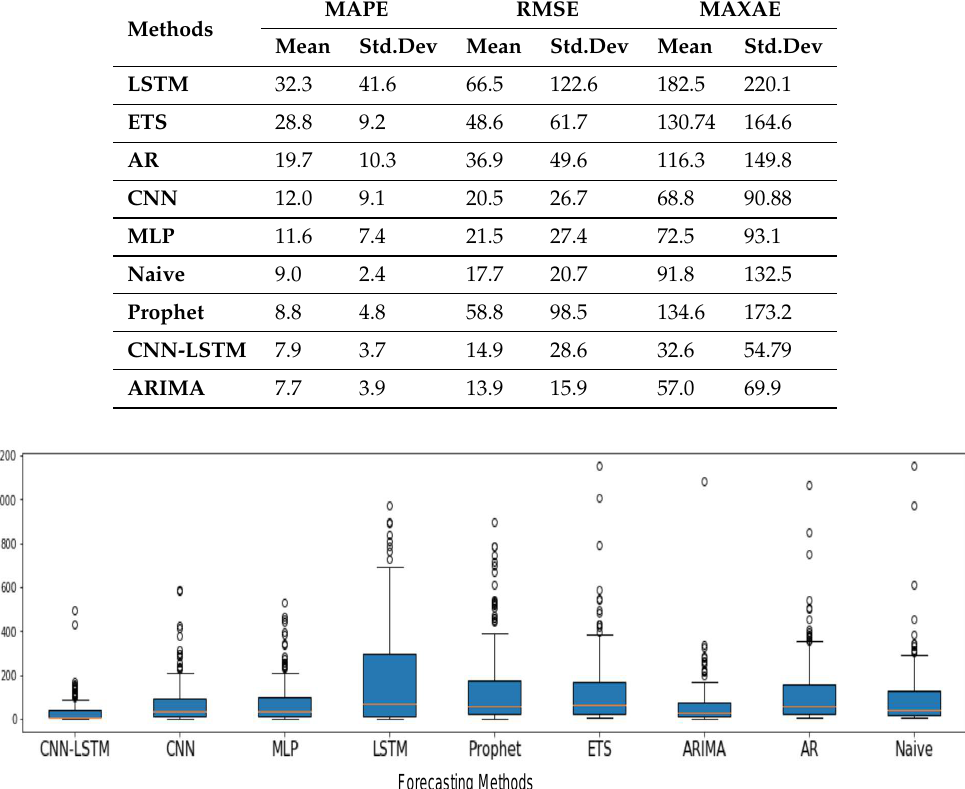
Figure 13. The distribution of MAXAE in a 24-h-ahead